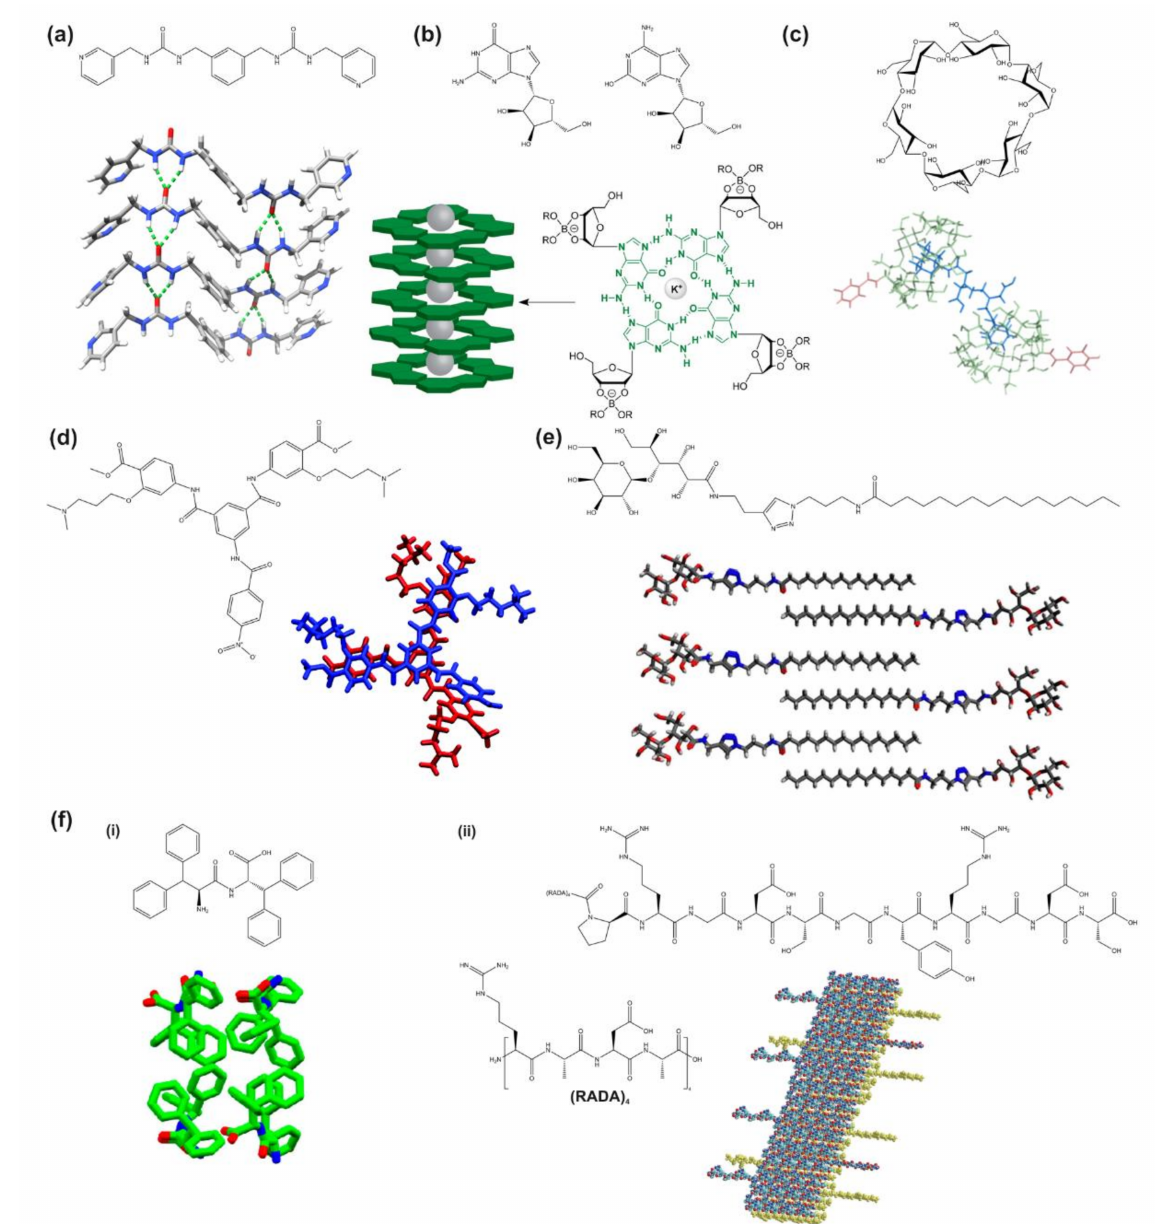
Figure 1. Schematics of representative molecules from different classes of supramolecular hydrogelators showing the chemical structures and how they are hypothetically interacting to self-assemble, including ( a ) bis-urea derivatives, ( b ) nucleosides and nucleoside derivatives, ( c ) cavity-bearing molecules, ( d ) polyaromatic compounds, ( e ) saccharide derivatives, and ( f ) amino acids and peptides and their derivatives. The schematics of the self-assembled structures